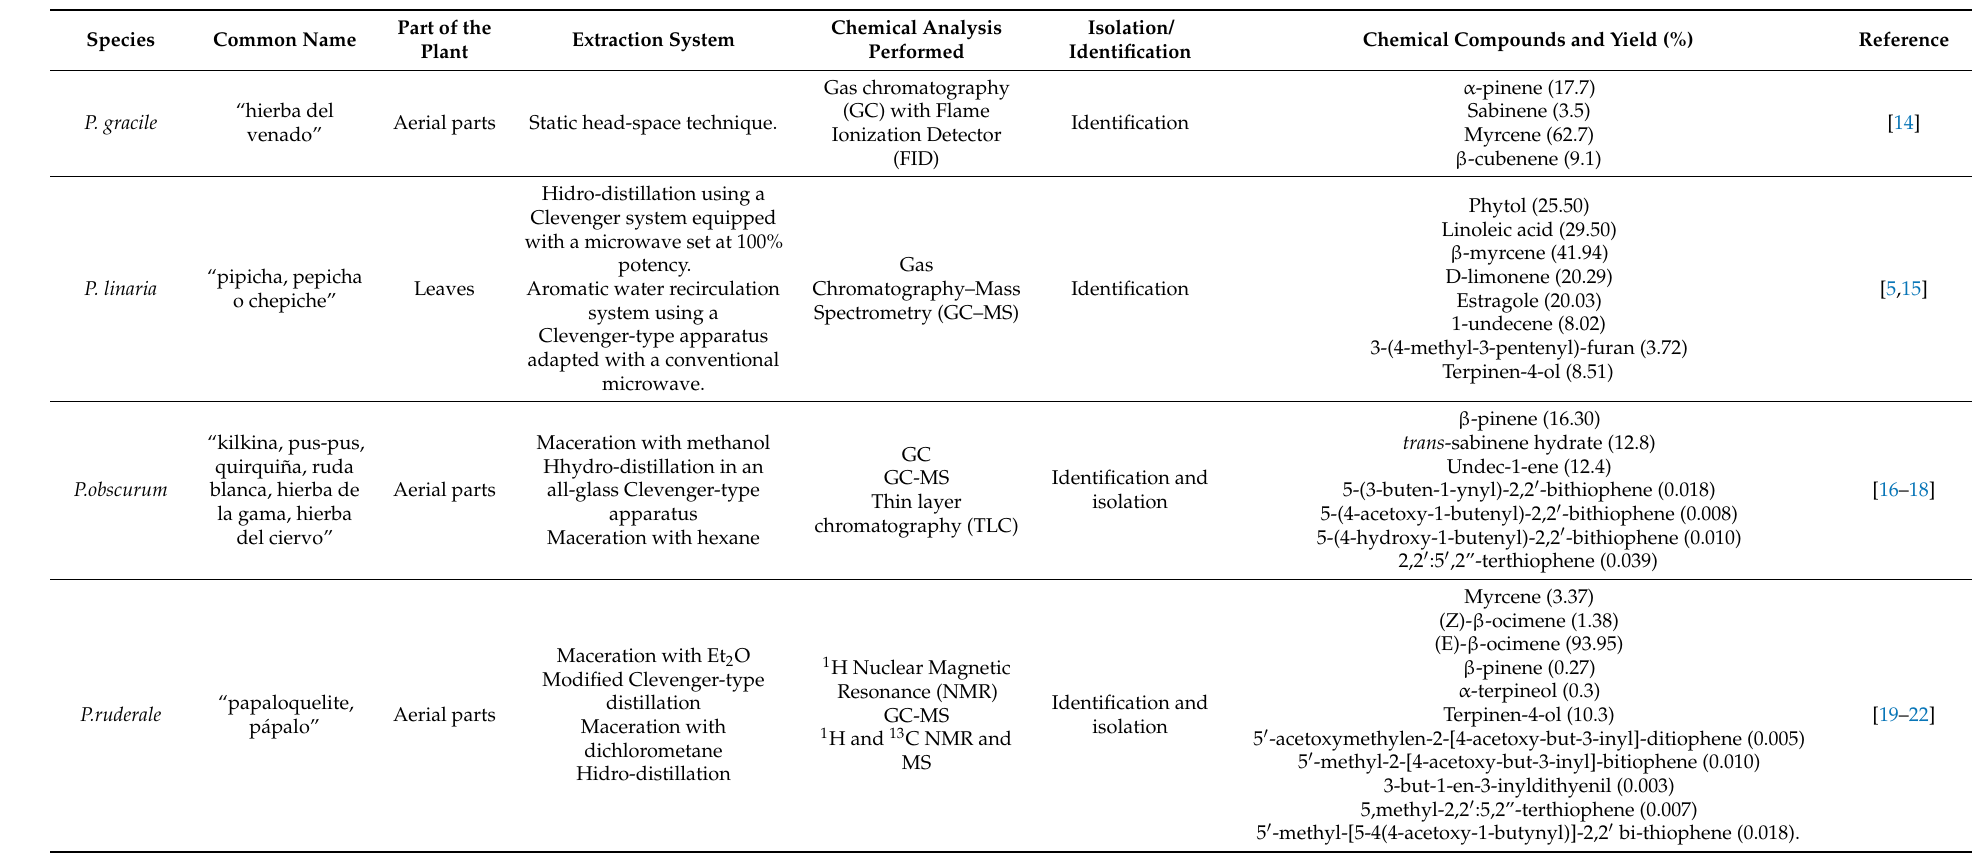
Table 1. Chemical constituents from plants of the genus